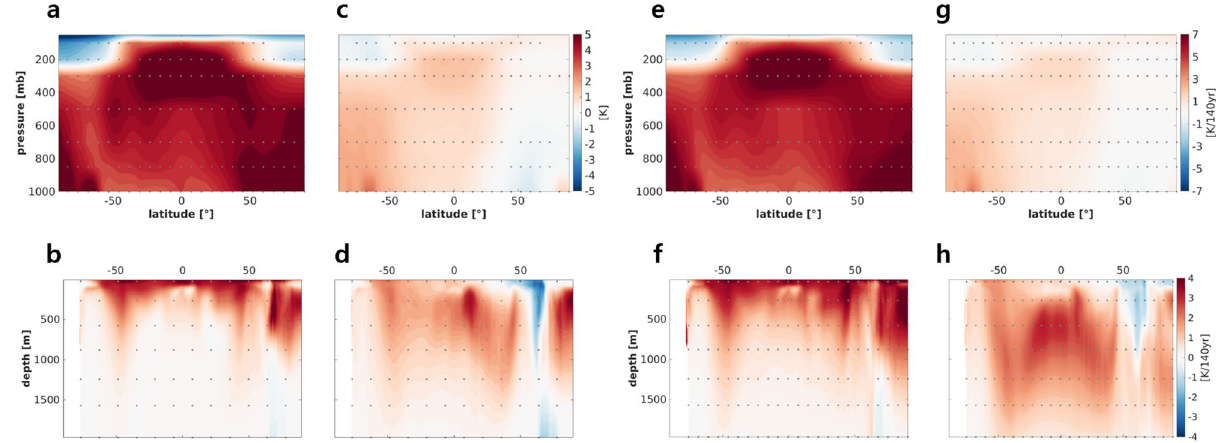
Figure 2. Time- and zonal-means of ( a ) atmospheric temperature and ( b ) oceanic potential temperature deviations from PI experiment in the ON50Y period. ( c ) and ( d ) As in ( a ) and ( b ), respectively, but for OFF50Y. Linear trends in ( e ) zonal-mean atmospheric temperature and ( f ) zonal-mean ocean potential temperature for the CO 2 ramp-up period obtained from the 4 × CO 2 CDR experiment. ( g ) and ( h ) As in ( e ) and ( f ) but for sum of linear trends from the CO 2 ramp- and -down periods, respectively. Units are given on the right-hand side of each panel. Dots in the figures indicate statistically significant points above 99% confidence tested by the bootstrap